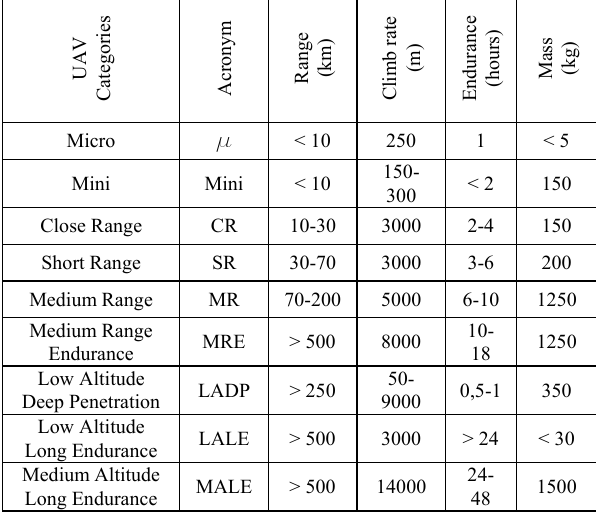
Table 1. Classification of UAVs according to Unmanned Aerial Vehicle Systems Association (Bendea et al.